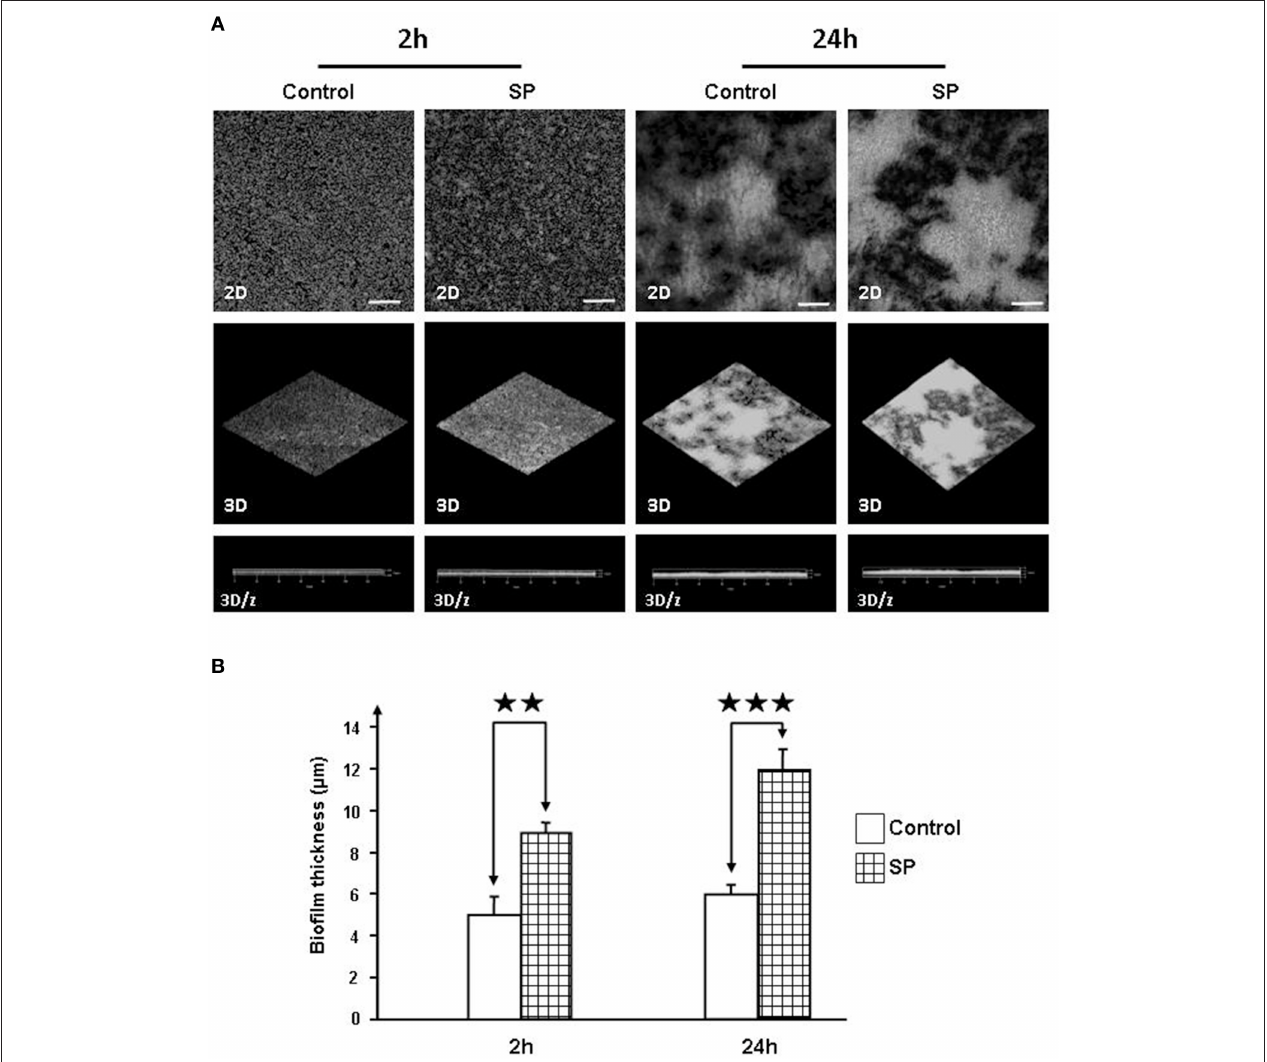
FIGURE 7 | Effect of Substance P reverse SPrev (Control) and Substance P (SP) (10 − 6 M) on the biofilm formation activity of S. epidermidis MFP04. The biofilm formation activity of bacteria was observed after 2, 5, and 24 h. (A) Two dimensions (2D), reconstructed three-dimensions (3D) and ortho cuts (3D/z) images. Pictures are representative of three independent experiments. (B) Evolution of the thickness of the biofilm after 2 and 24 h incubation with SP. Each value represents the mean ± SEM of three independent experiments ( ⋆⋆ p < 0.01; ⋆⋆⋆ p <